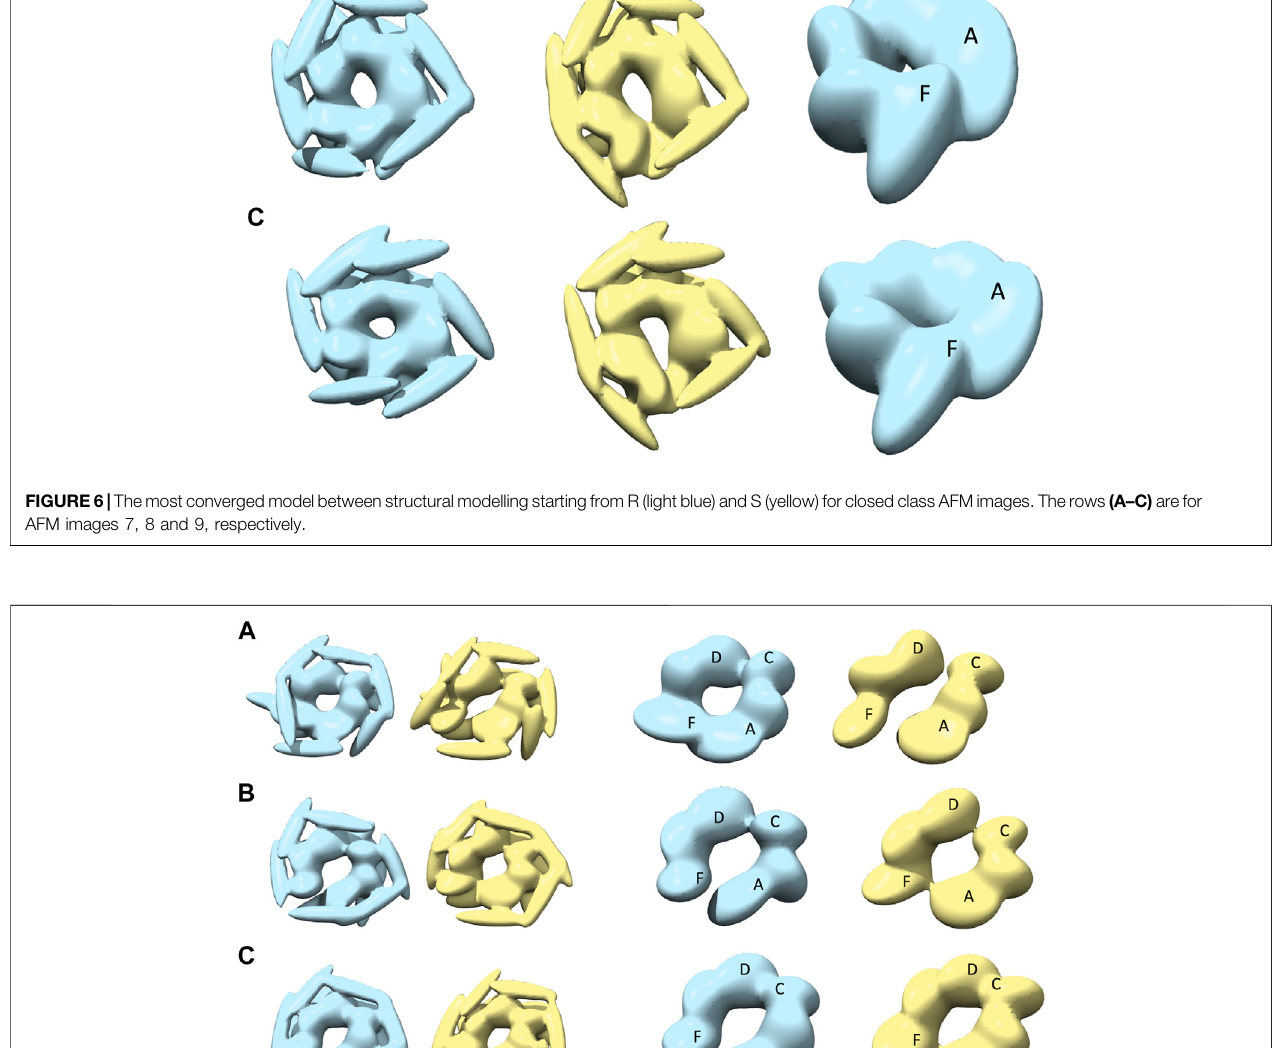
( Supplementary Figure 5A ) and found high similarity in most of the cases. We observed that the conformational variation is mostly due to the orientation of the fl exible coiled-coil domain